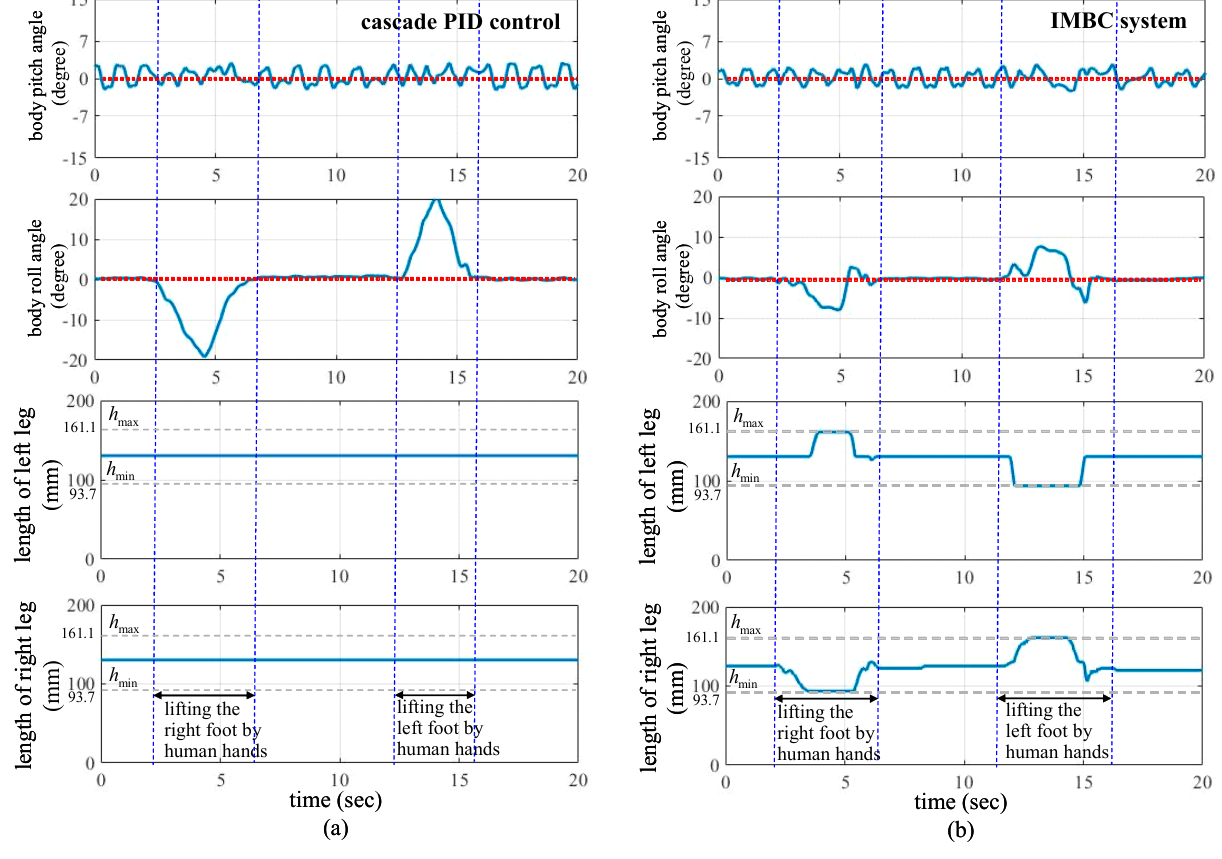
Figure 9. Results of body balancing. ( a ) Cascade PID control; ( b ) the IMBC system.